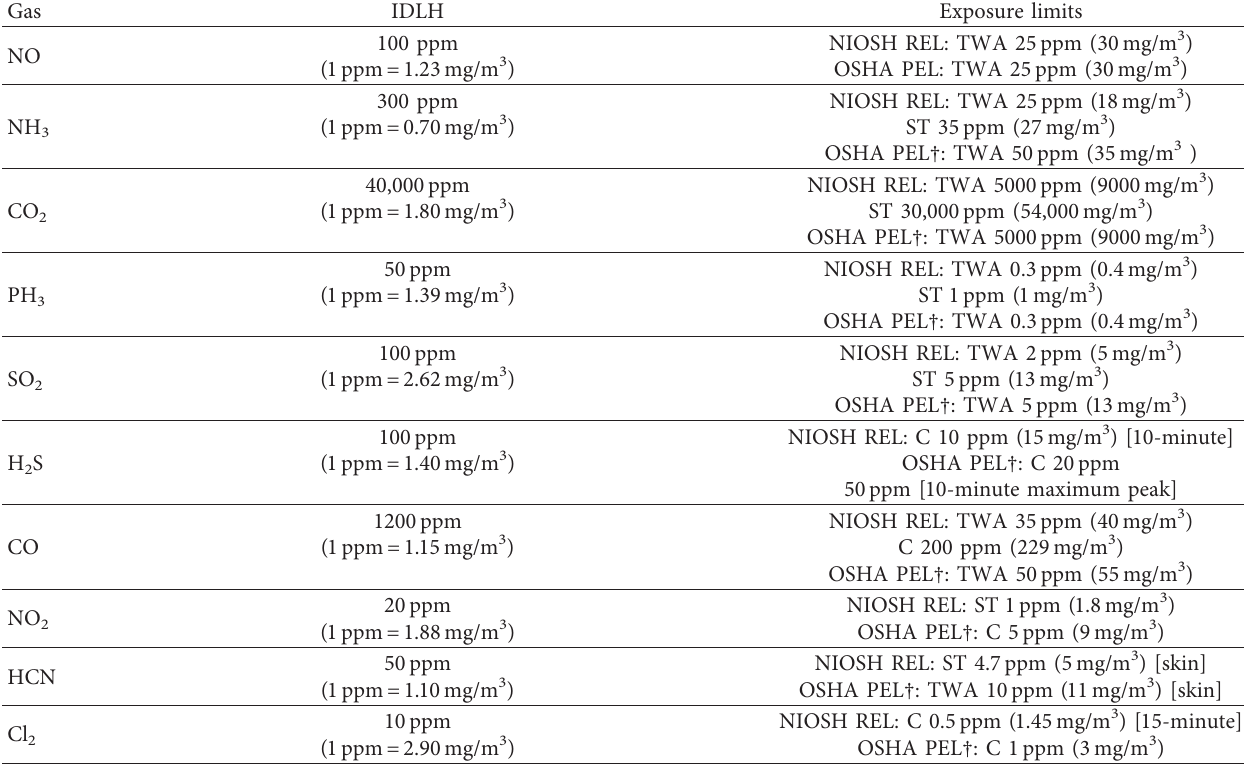
Table 4: The standard immediately dangerous to life or health concentrations (IDLH) and exposure limits [48] of gases detected in